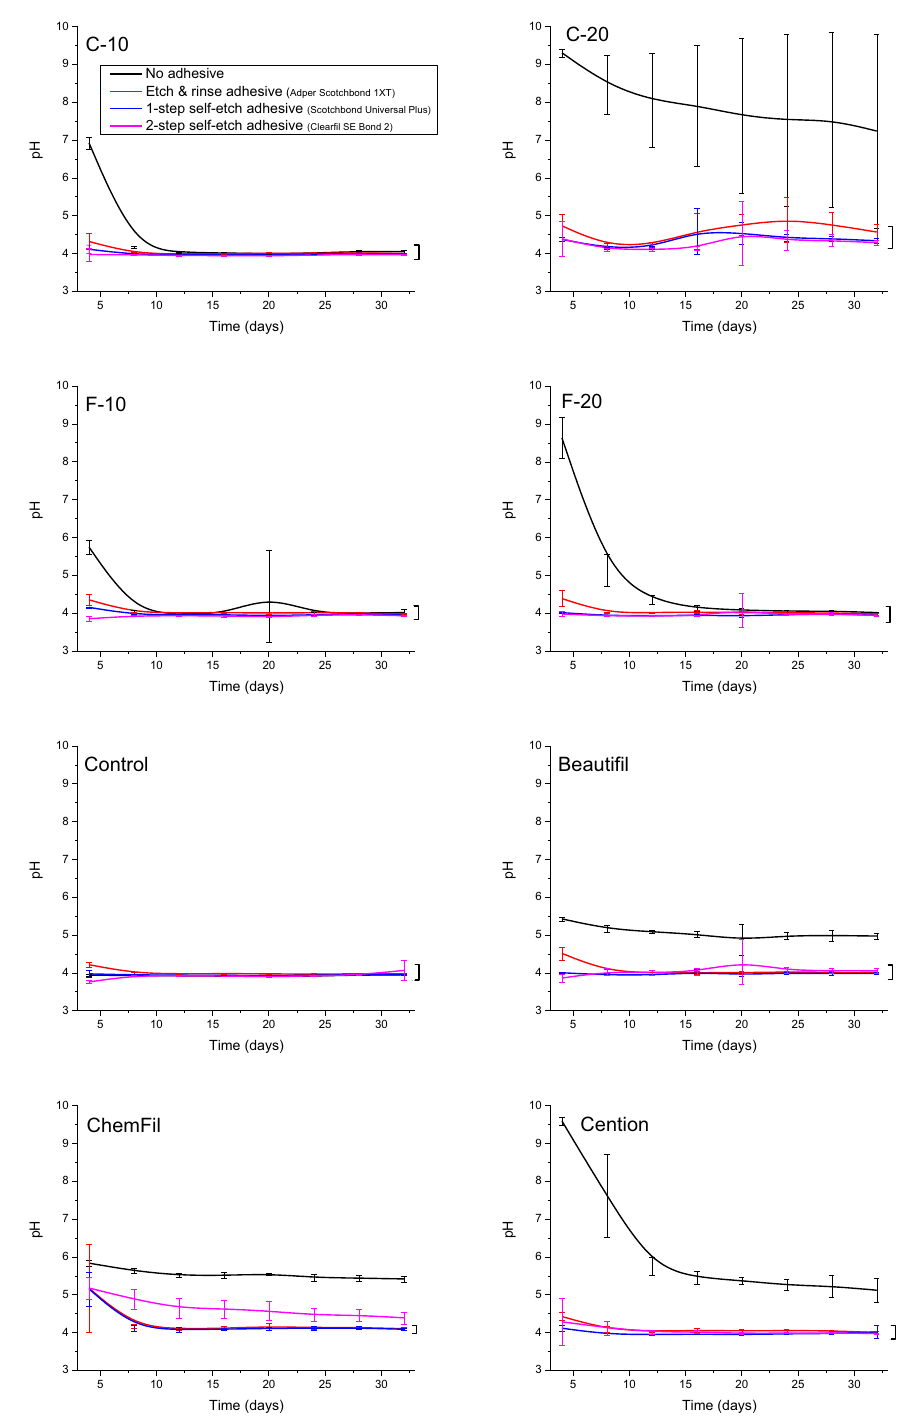
Figure 5. pH changes of immersion solution over 32 days. Square brackets indicate statistically similar values at the end of the observation